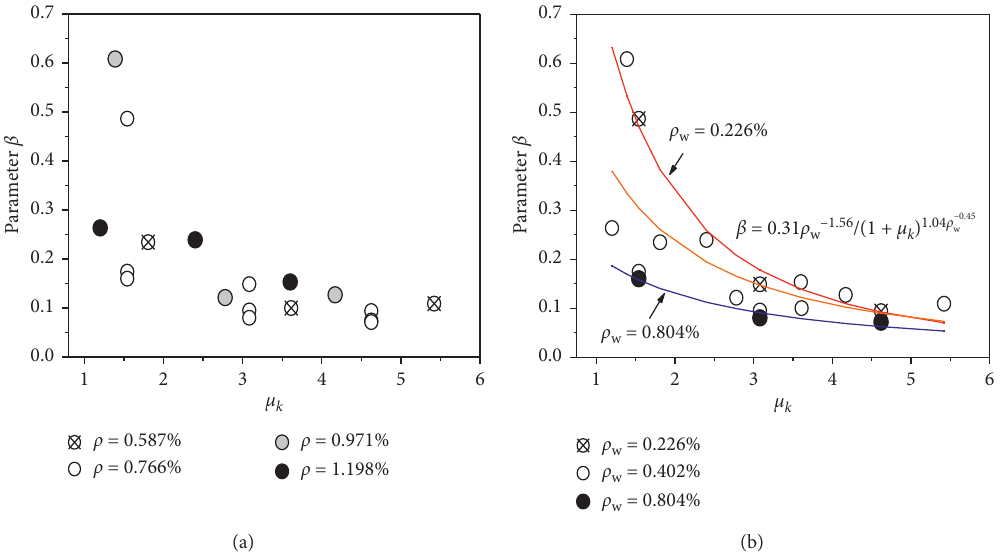
Figure 9: Relationship between μ k and parameter β . (a) Different symbols represent the difference in ρ . (b) Different symbols represent the difference in ρ w